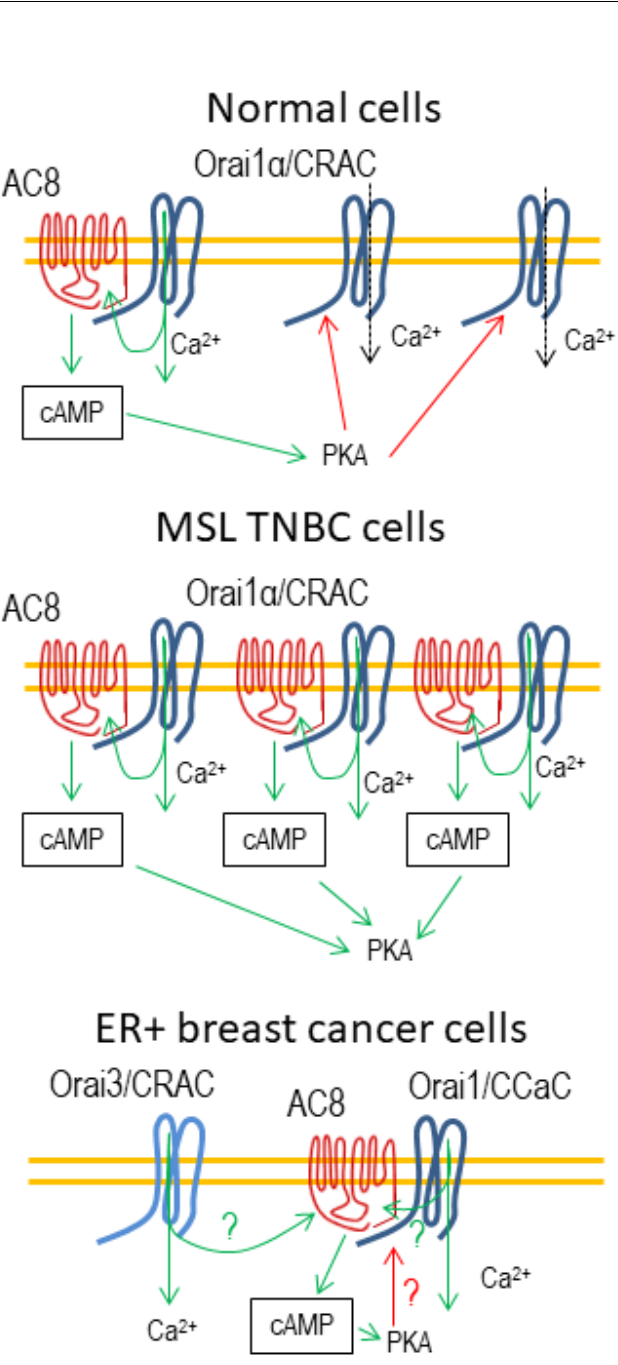
Figure 3. Cartoon depicting the AC8-Orai interplay in normal and breast cancer cells. Only one Orai subunit of the CRAC channel hexameric structure is depicted for clarity. In normal cells, Orai1 plays a predominant role in CRAC channels. Ca 2+ influx through Orai1 α leads to the activation of AC8, which in turn results in the activation of cAMP-dependent protein kinase (PKA) and inactivation of the AC8-free Orai1 α subunits by phosphorylation at serine-34, thus moderating SOCE. In mesenchymal stem-like (MSL) TNBC cells Orai1 is the major component of CRAC channels. In these cells, AC8 overexpression decreases the number of AC8-free Orai1 α subunits susceptible to phosphorylation and inactivation, leading to enhanced SOCE. In ER+ breast cancer cells, SOCE is mediated by Orai3, which is unable to bind AC8, and Orai1 participates in SPCA-dependent constitutive Ca 2+ entry (CCaC). AC8 activation is activated by still unknown mechanisms that might involve Ca 2+ influx via Orai1 or Orai3 in the close vicinity of Orai1 channels. The possible inactivation of Orai1-forming CCaCs by PKA remains